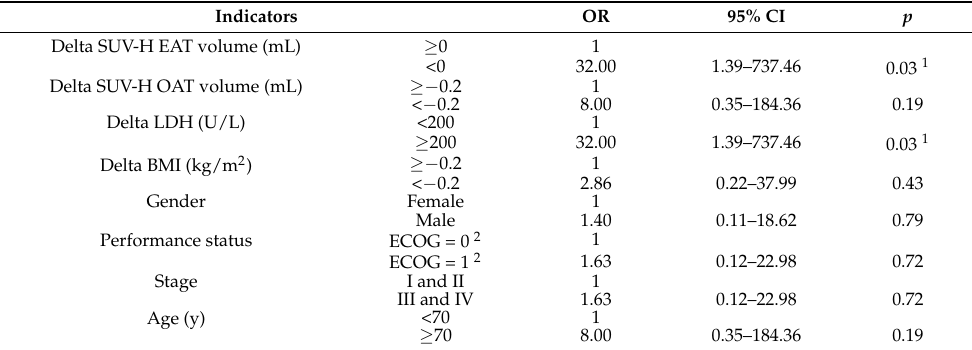
Table 6. Logistic regression analysis for possible indicators of